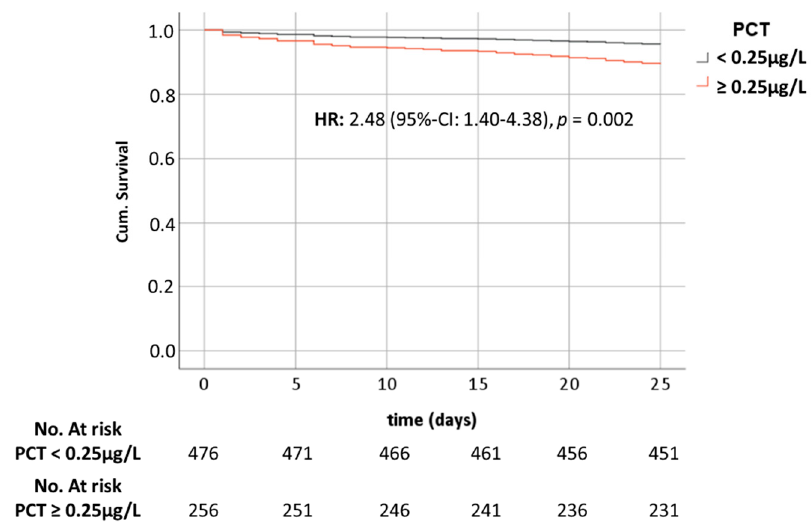
Figure 2. Cumulative survival within 28 days of admission to the ED for patients with procalcitonin (PCT) below, at, or above 0.25 µg/L. Abbreviations: HR—Hazard Ratio. CI- confidence intervalX; Cum: cumulative.